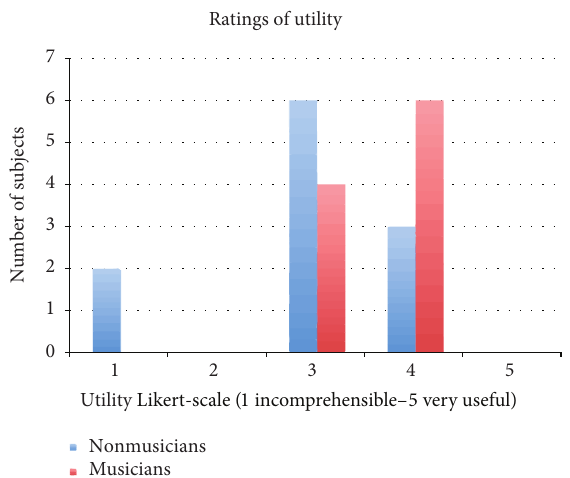
Figure 14: Chart of ratings of experience utility (average of ratings 2.9 for nonmusicians and 3.6 for musicians).